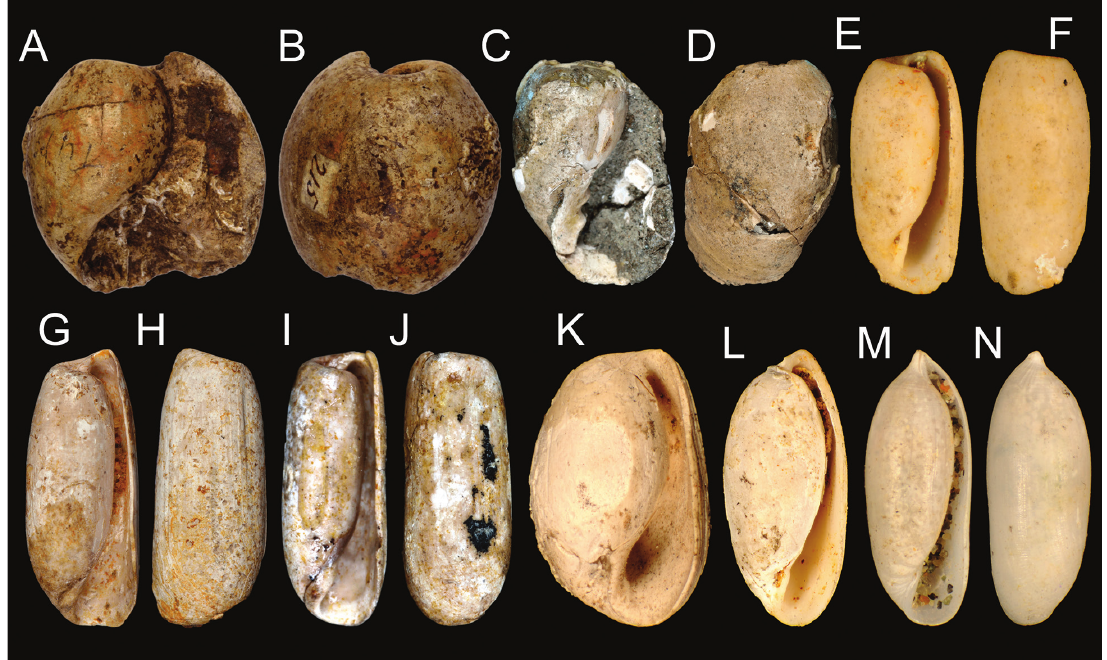
Figure 5. Types. A–B. Holotype of Bulla macrostoma , H 26.2 mm, ANSP IP30727. C–D. Holotype of Bullopsis cretacea , H 18.0 mm, ANSP IP18924. E–F. Holotype of Retusa biforis , H 2.9 mm, ANSP IP3192. G. Paralectotype of Retusa galba , H 14.3 mm, ANSP IP53816. H. Lectotype of Retusa galba , H 15.0 mm, ANSP IP30548. I–J. Lectotype of Retusa sthillairii , H 14.0 mm, ANSP IP5486. K. Syntype of Retusa subspissa , H 4.8 mm, ANSP IP30641. L. Holotype of Volvulella cylichnoides , H 4.2 mm, ANSP IP3177. M–N. Syntype of Volvulella cylindrica , H 4.7 mm, ANSP